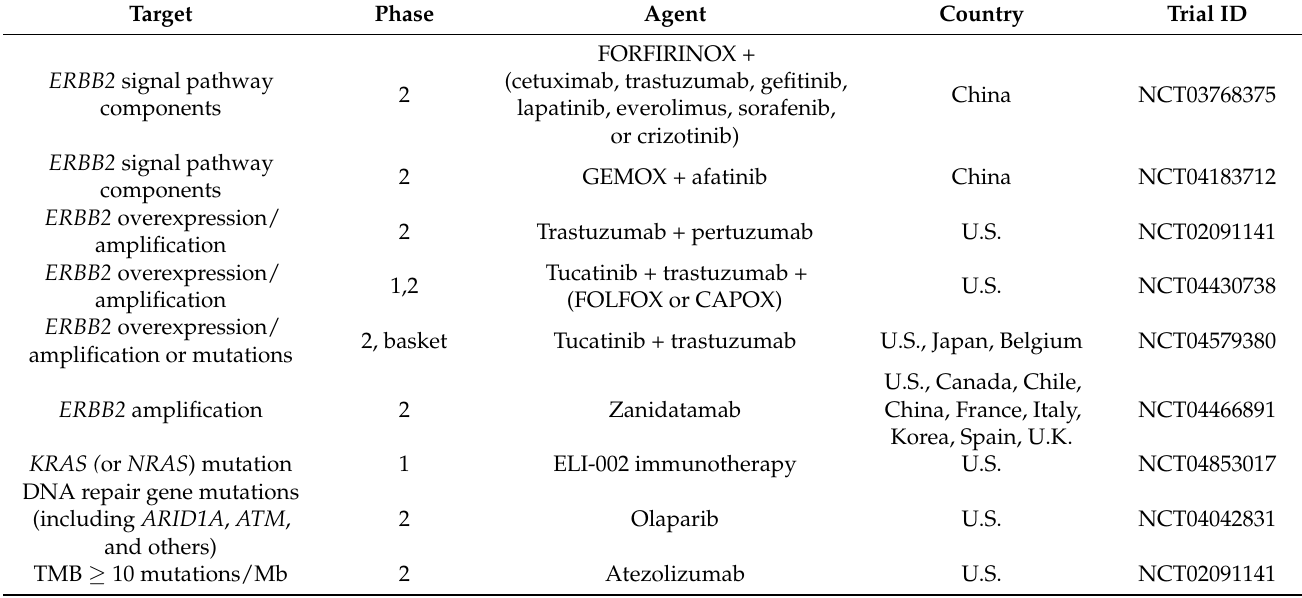
Table 5. Ongoing clinical trials targeting genetic alterations in